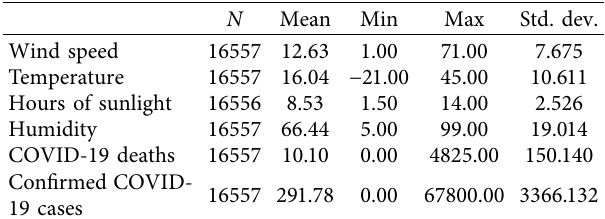
Table 1: Descriptive statistics.